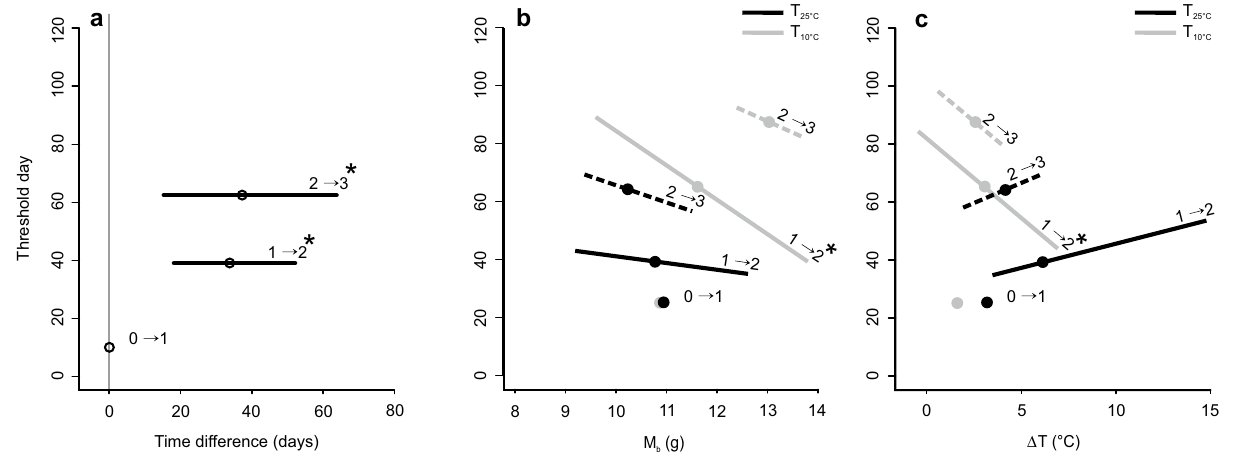
Figure 3. Sexual maturation rate of bats in the two treatments. The y-axis shows the average experimental day on which T 25°C bats reached the next consecutive maturation class. ( A ) Delay in time until T 10°C bats reached the same threshold. The y-axis shows the average day since the beginning of the experiment on which T 25 °C bats reached the next consecutive maturation class. The x-axis shows the delay in time until T 10 °C bats reached the same class. Each delay is presented with its 95% credible intervals (CI). ( B ) The effect of M b (body mass) on the time of transition to consecutive classes. ( C ) The effect of ΔT (difference between T sk and T a ) on the transition time to consecutive classes. Asterisks indicate significant effects.